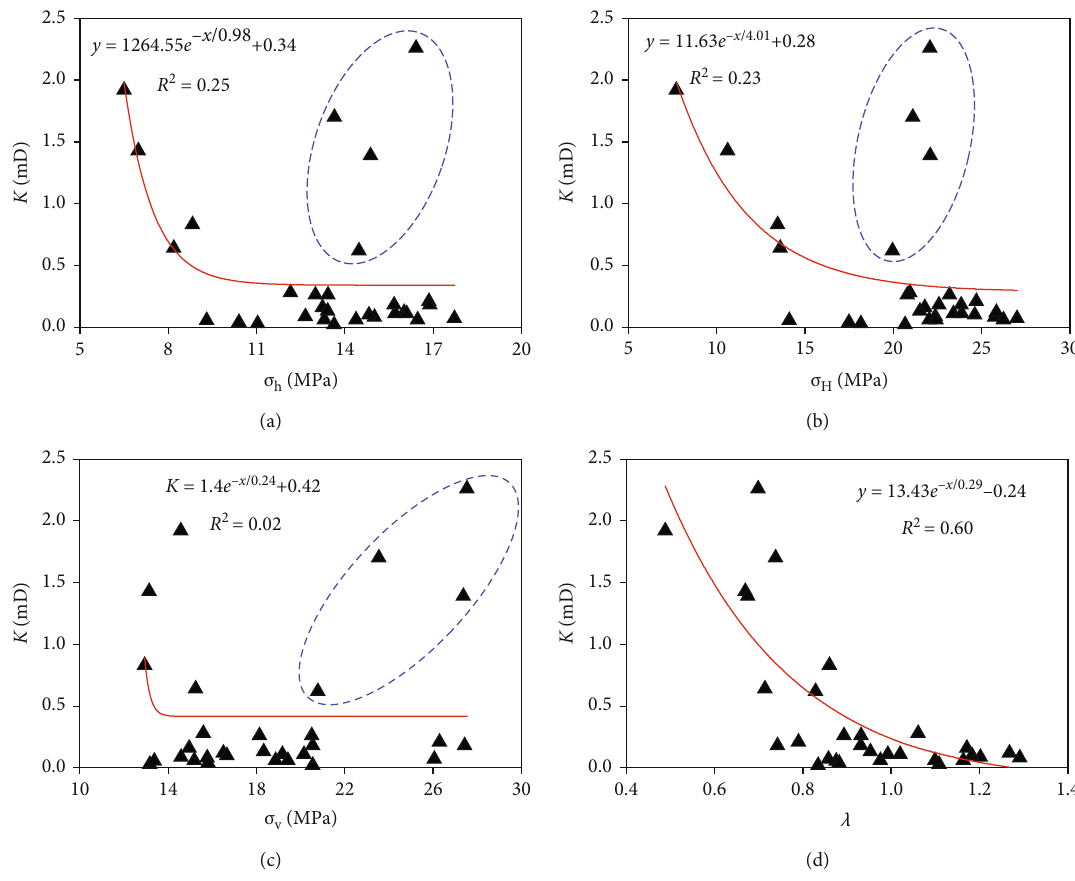
Figure 9: Scatter plot of permeability and some parameters. Table 2: Statistical table of structural locations of data points with high